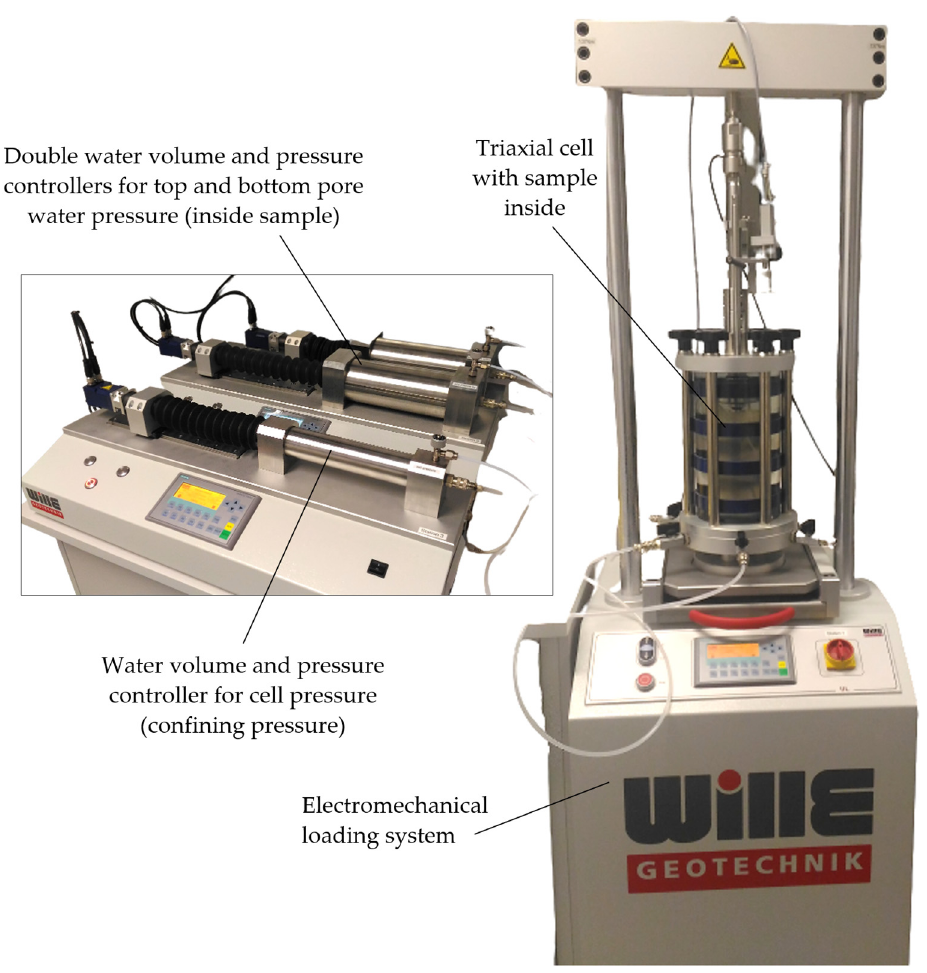
Figure 5. Triaxial compression apparatus for permeability tests.